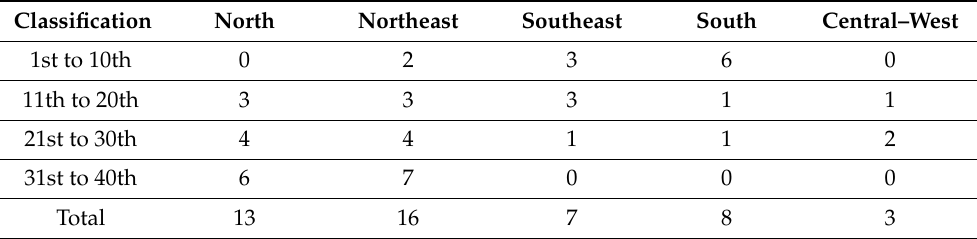
Table 11. Number of cities by region according to position in the ranking.